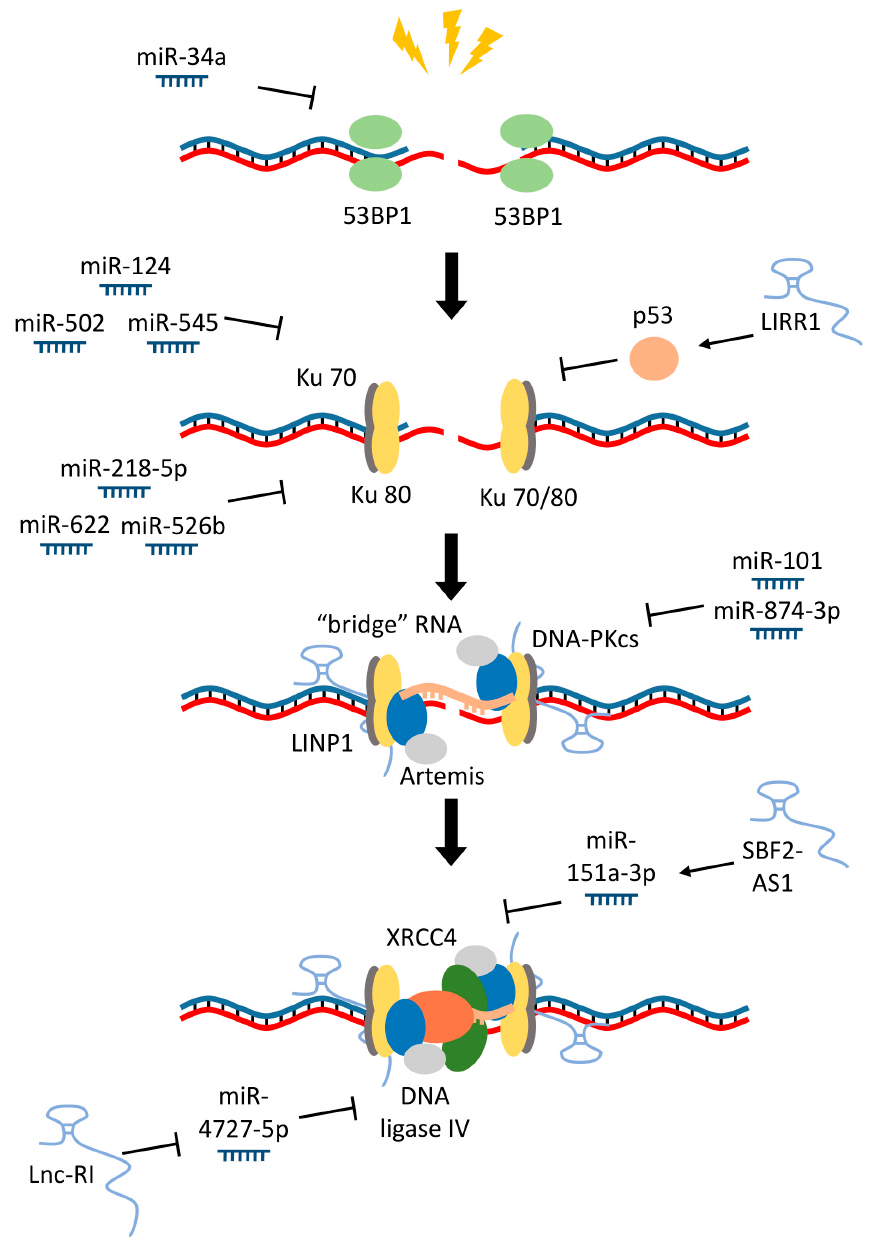
Figure 5. RNAs that regulate nonhomologous end-joining (NHEJ). At the first stage of NHEJ, the p53-binding protein 1 (53BP1) binds to the break region. The synthesis of the protein is controlled by miR-34a. Next, the Ku70/Ku80 heterodimer and DNA-dependent protein kinases (DNA-PKcs) are recruited to the damaged region. The stability of these three factors mRNA is controlled by the following miRNA: miR-124, miR-502 and miR-545 (Ku70); miR-526b, miR-622 and miR-218–5p (Ku80); miR-101 and miR-874-3p (DNA-PKcs). Furthermore, long intergenic radiation-responsive ncRNA1 (LIRR1) suppresses the expression of Ku70 and Ku80 by activating p53. lncRNA in nonhomologous end-joining pathway 1 (LINP1) to participate in the assembly of a complex with Ku80 and DNA-PKcs. “Bridge” RNA could hold together the DNA strands in the break area. At the last stage, DNA ligase IV and its cofactor X-ray repair cross-complementing protein 4 (XRCC4) link the free ends of the DNA, eliminating the break. Expression of DNA ligase IV and XRCC4 is controlled by miR-4727-5p and miR-151a-3p correspondingly. These miRNAs are blocked by lncRNA radiation-induced (lnc-RI) and SBF2 Antisense RNA 1